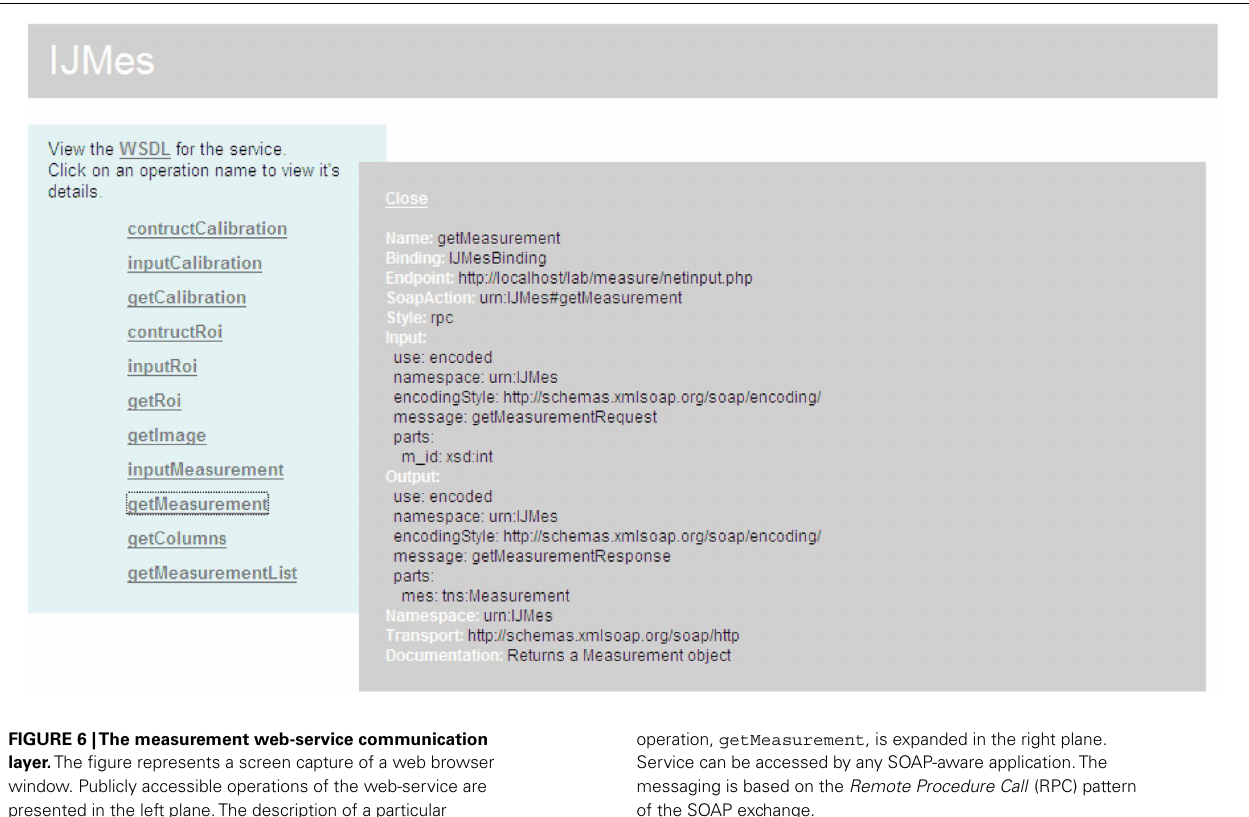
FIGURE 6 |The measurement web-service communication layer. The figure represents a screen capture of a web browser window. Publicly accessible operations of the web-service are presented in the left plane.The description of a particular